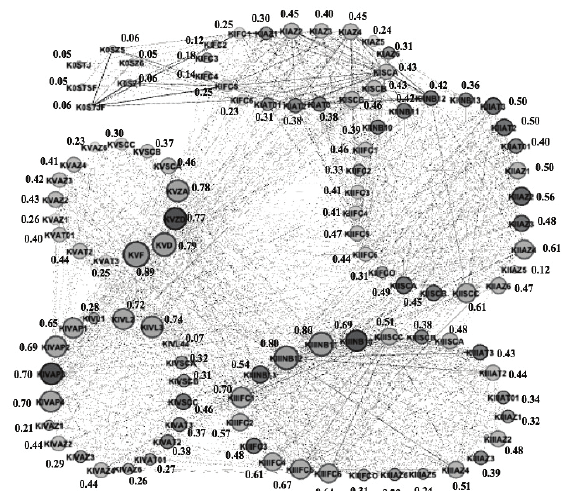
FIGURE 3. Network with Eigenvector Centrality for all variables related to the efficacy 2 in women’s volleyball. Terminology: in each node, codes are represented by the name of complex (e.g., KII), followed by the variable and its category (e.g., KIIAZ6 indicates that the action occurred in complex II, the variable in question was Attack Zone, and the category is Zone 6). Codes for the different variables: IPS – Initial Position of the Serve; ST – Serve Type (Jump, Jump-Float and Standing-Float); FC – Zone of First Contact; SC Setting Condition; AZ –Attack Zone; AT – Attack Tempo; BO – Block Opposition; KIVB – Number of Available Player Before of Attack Coverage; KIVL – Number of Coverage Lines; KVD and KVF – Downball and Freeball; KVTZ –Target Zone in KV (Attack or Defence Zone). Our results further highlighted, for Efficacy 2 (i.e.,